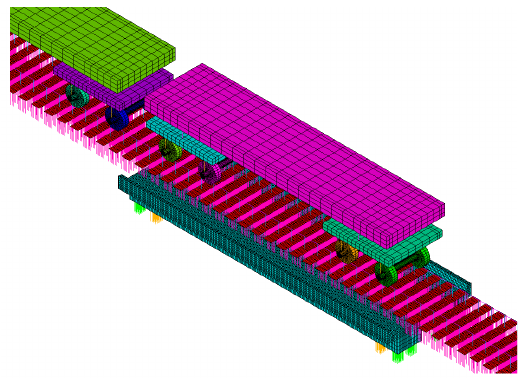
Figure 19. A dynamical finite-element-based model for vehicle–track–bridge system.